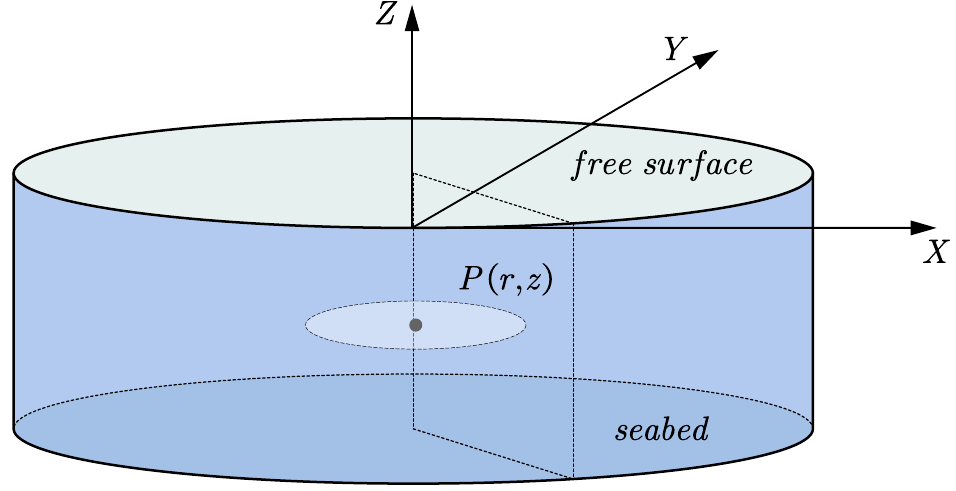
Figure 4. A point source in a cylindrical domain.